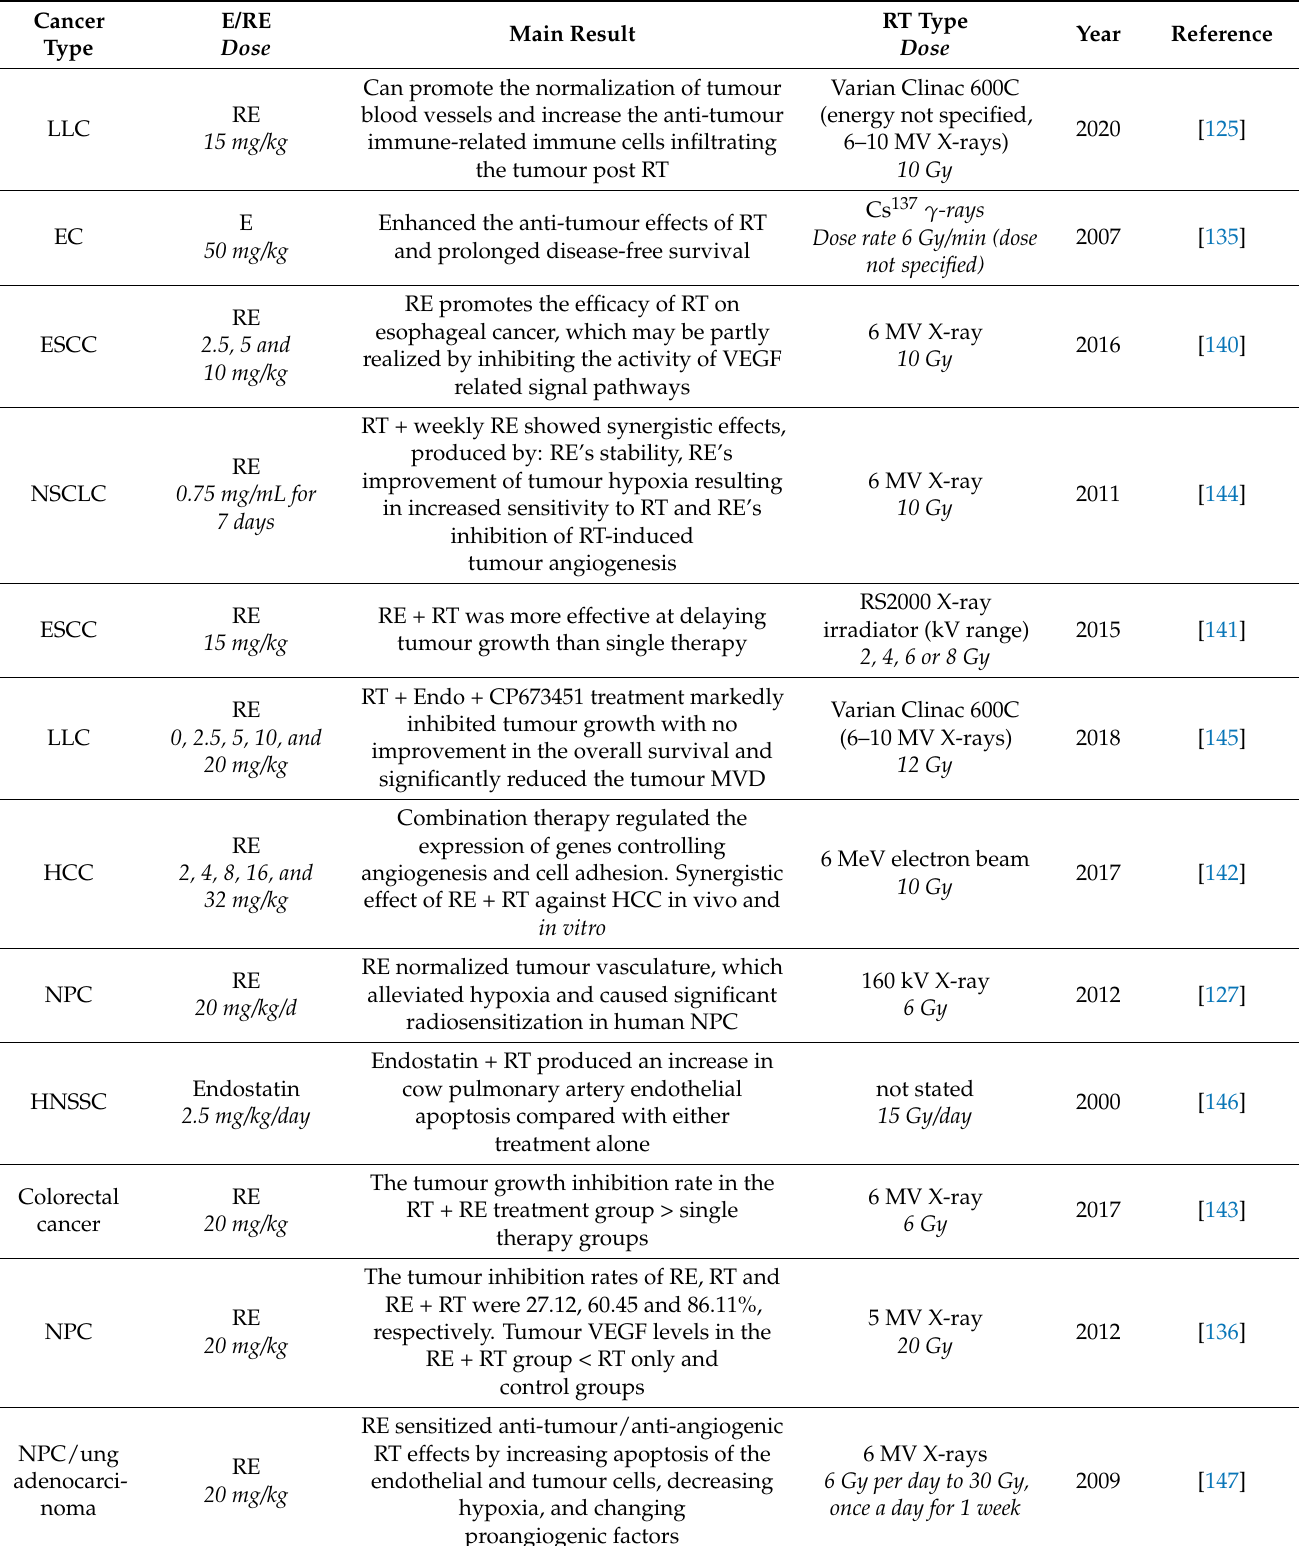
Table 2. Endostatin combined with radiotherapy in vivo mouse